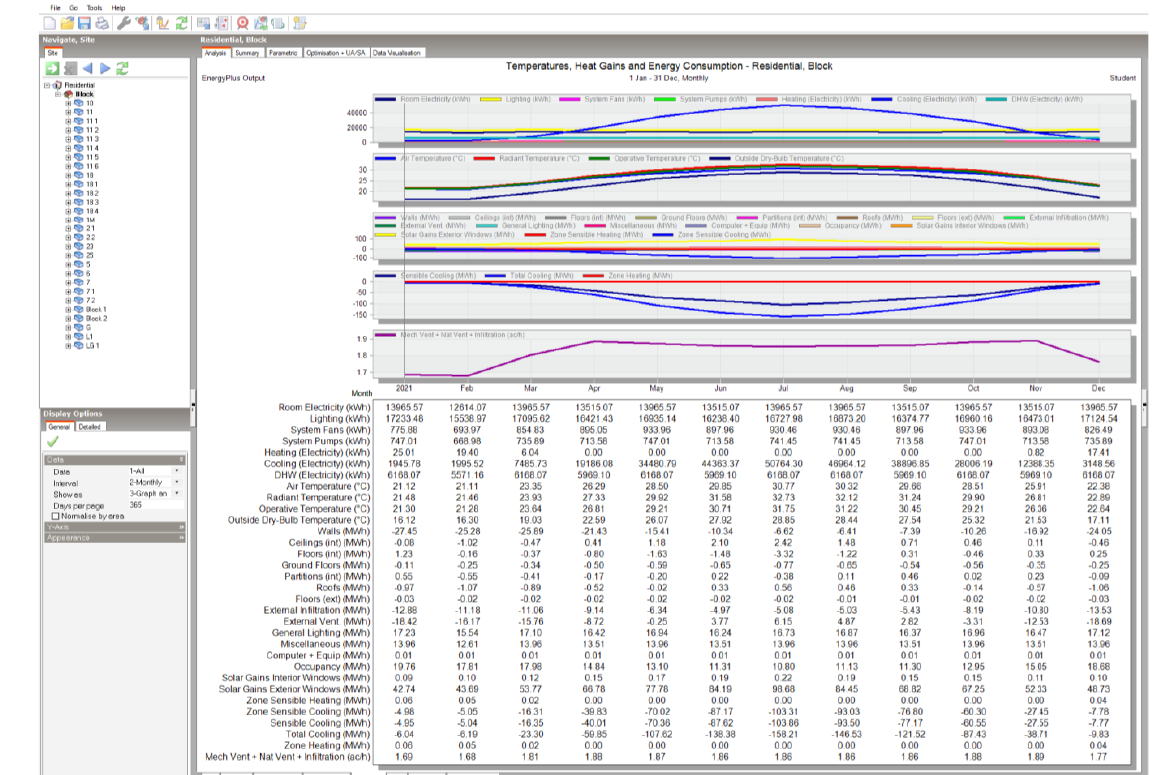
Figure 6. Energy simulation results for Model 1.